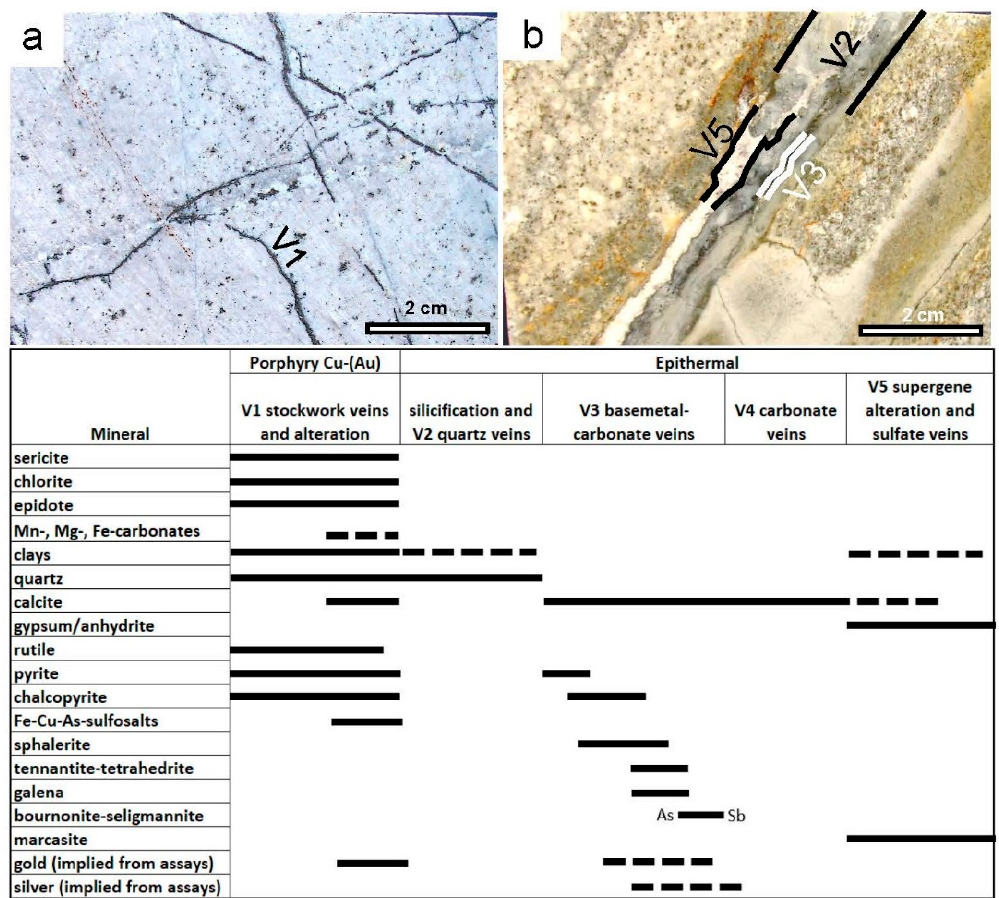
Figure 7. Paragenetic sequence of the Busang Southeast Zone from this study with examples. Dashed lines indicate that mineralization was minor or less common. The paragenesis was divided into porphyry and epithermal environments and further subdivided into substages, with an interpretation discussed below. Gold and silver were not directly observed but implied from their association with V1 and V3 stage minerals. ( a ) Stockwork style mineralization from sample BSSE-333B, and ( b ) banded quartz-carbonate-base metal-sulfate vein from sample BSSE-1A.